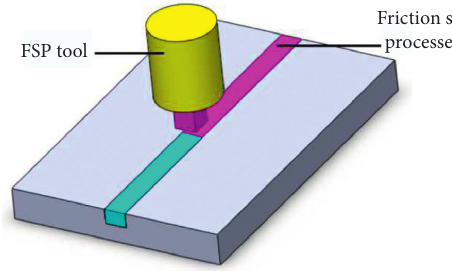
Figure 1: Friction stir